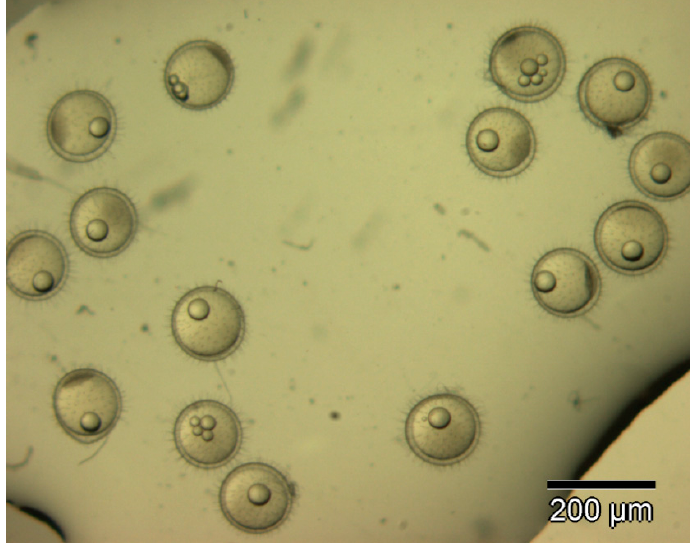
Figure 1. Medaka embryos in culture dish under microscope.